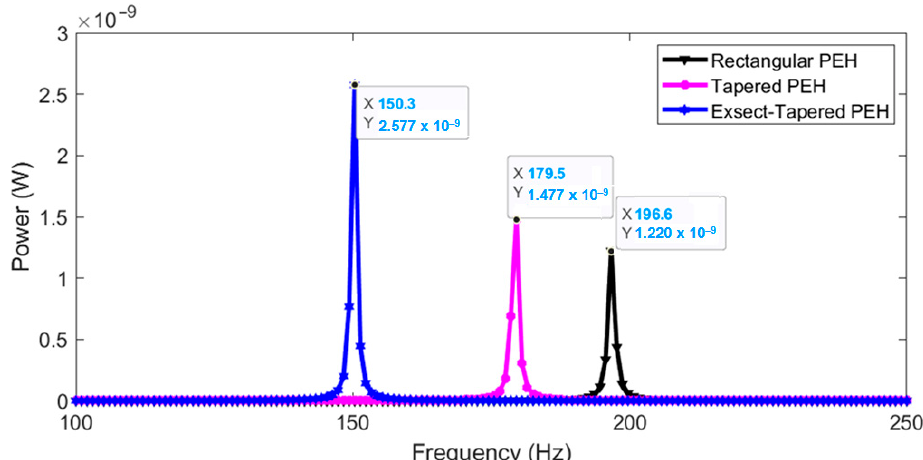
Figure 9. Numerically simulated frequency response (linear) of the PEHs for an input excitation of 0.001 g.